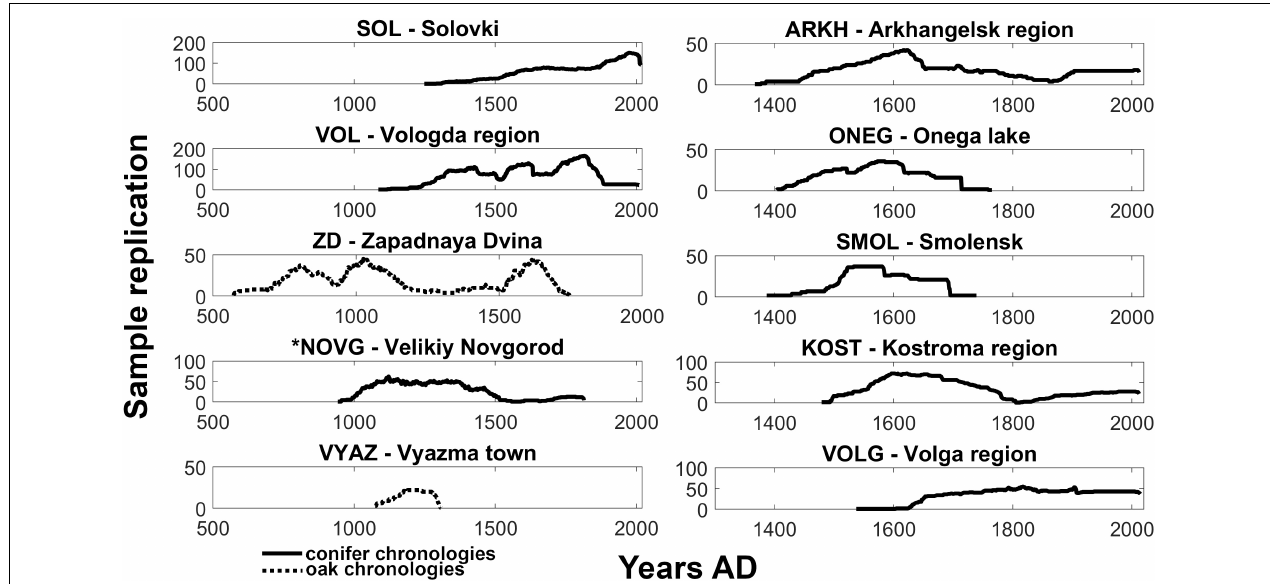
FIGURE 2 | Replication of long chronologies in European Russia. Note different axes. For the locations see Figure 1 . *Higher length and replication are reported by Tarabardina et al. (2016): 9th–19th centuries, 6,505 dated samples in total.